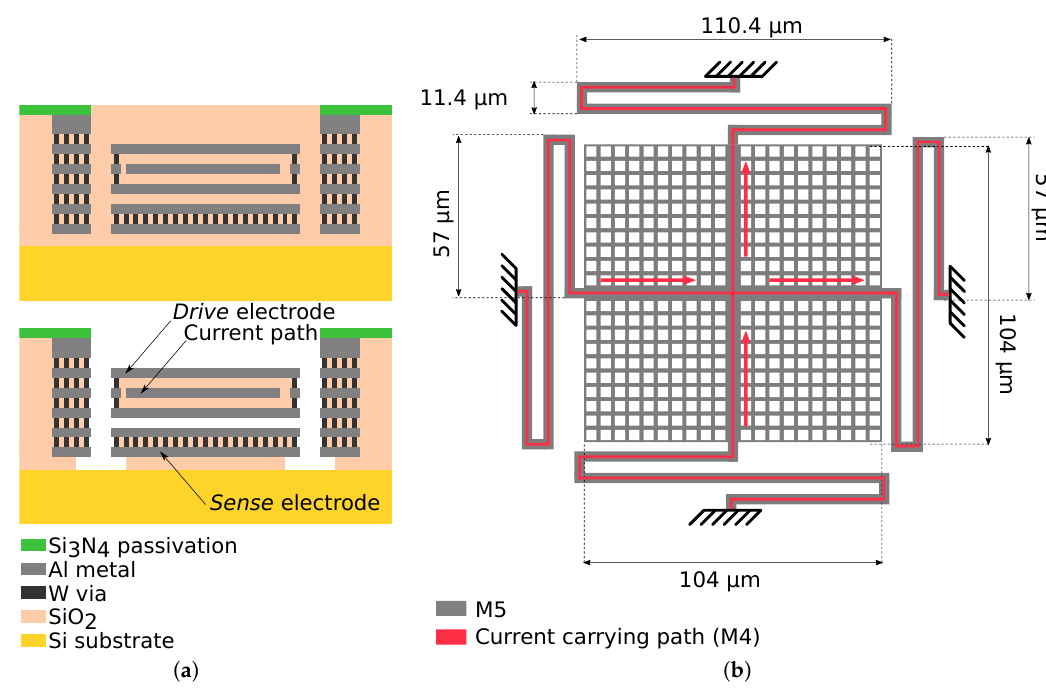
Figure 3. Device diagrams. In ( a ), simplified cross section diagram of the MEMS device manufactured using the BEOL layers of the CMOS process. On top, device at fab-out, below, after the release process with the different device parts depicted. In ( b ), device diagram with dimensions. The top-most metal layer (M5) is shown in grey, while the vertical and horizontal current carrying paths (M4) are shown in red. Red arrows show the different current flow directions that allow magnetic field measurement in two